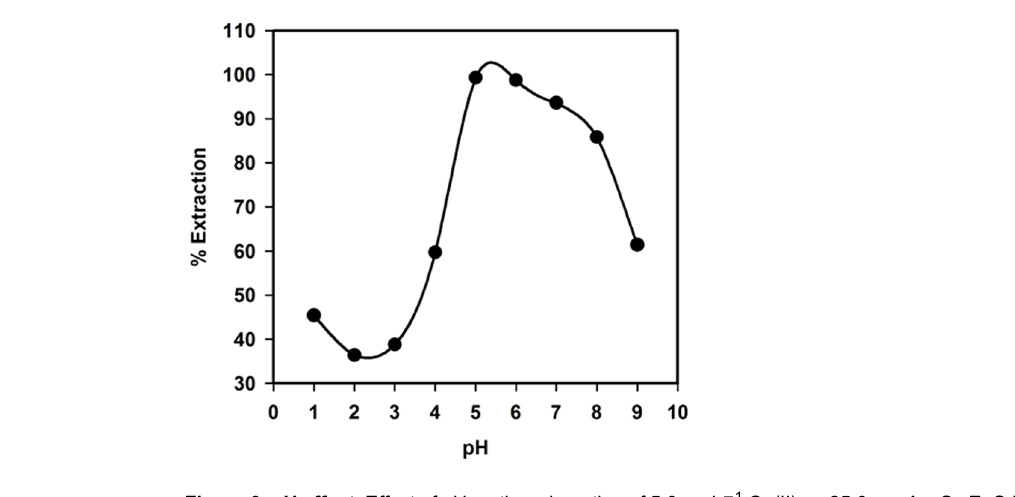
Figure 6. pH effect. Effect of pH on the adsorption of 5.0 mgL 2 1 Co(II) on 25.0 mg Ag 2 O 3 -ZnO NCs phase at 25.0 ˚ C.